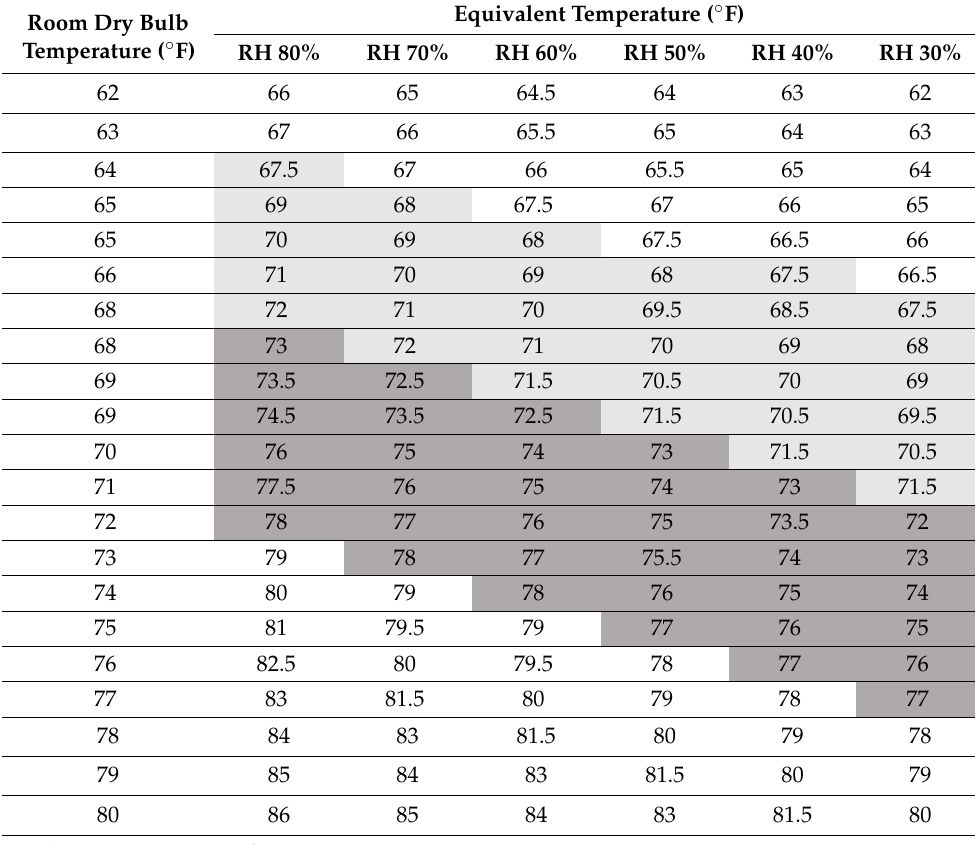
Light grey: Winter comfort range Dark grey: Summer comfort